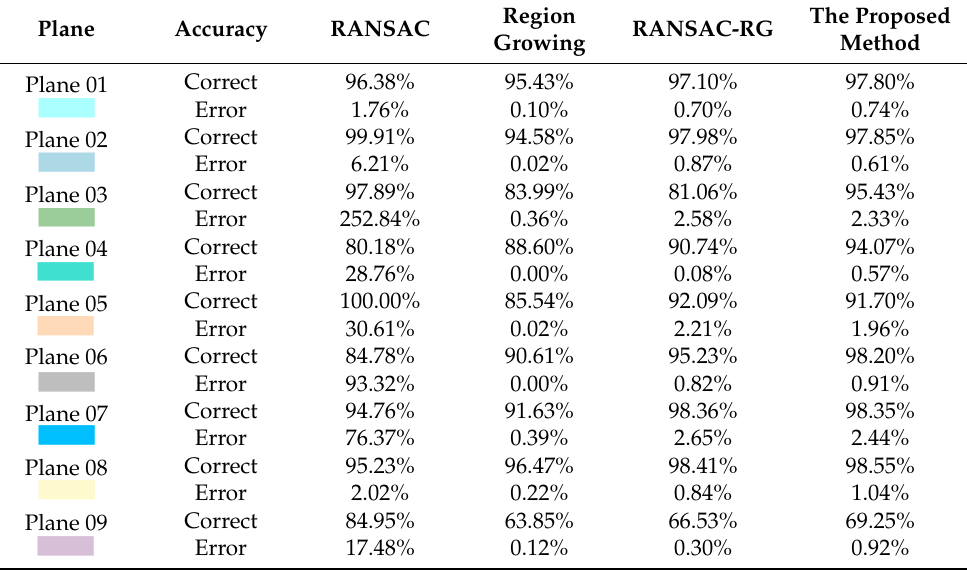
Table 5. Accuracy assessment of pantry’s plane segmentation.